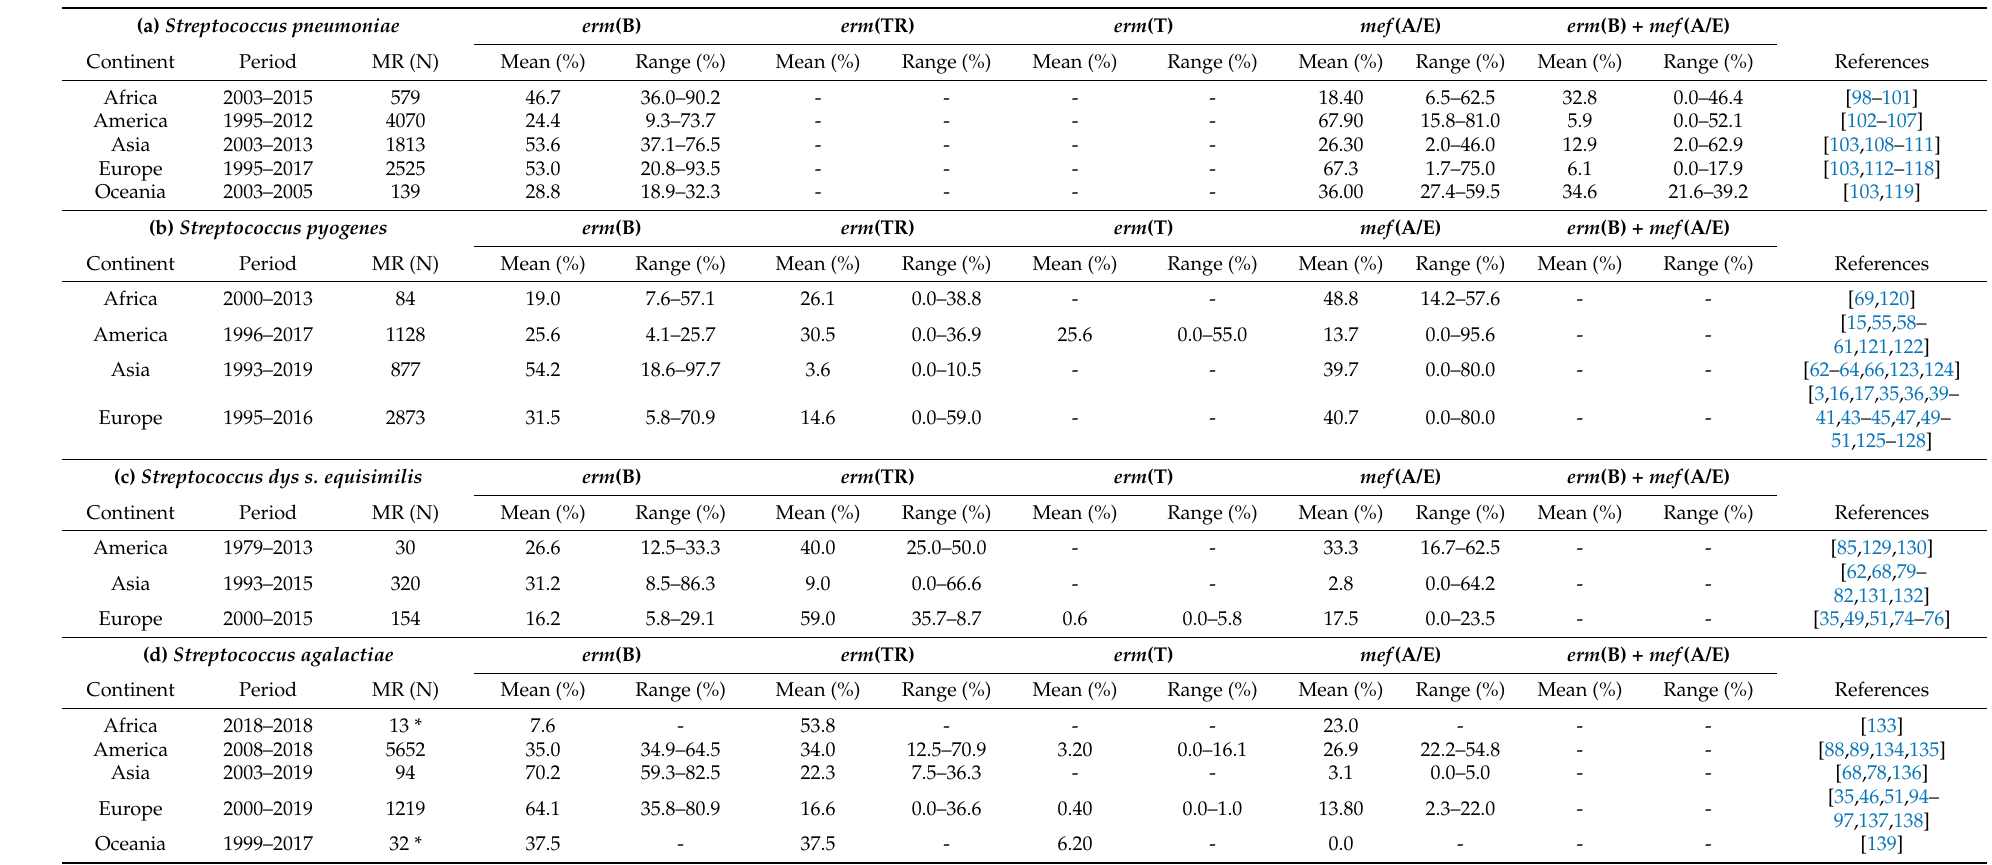
Table 2. Frequency of macrolide resistance determinants among different geographical